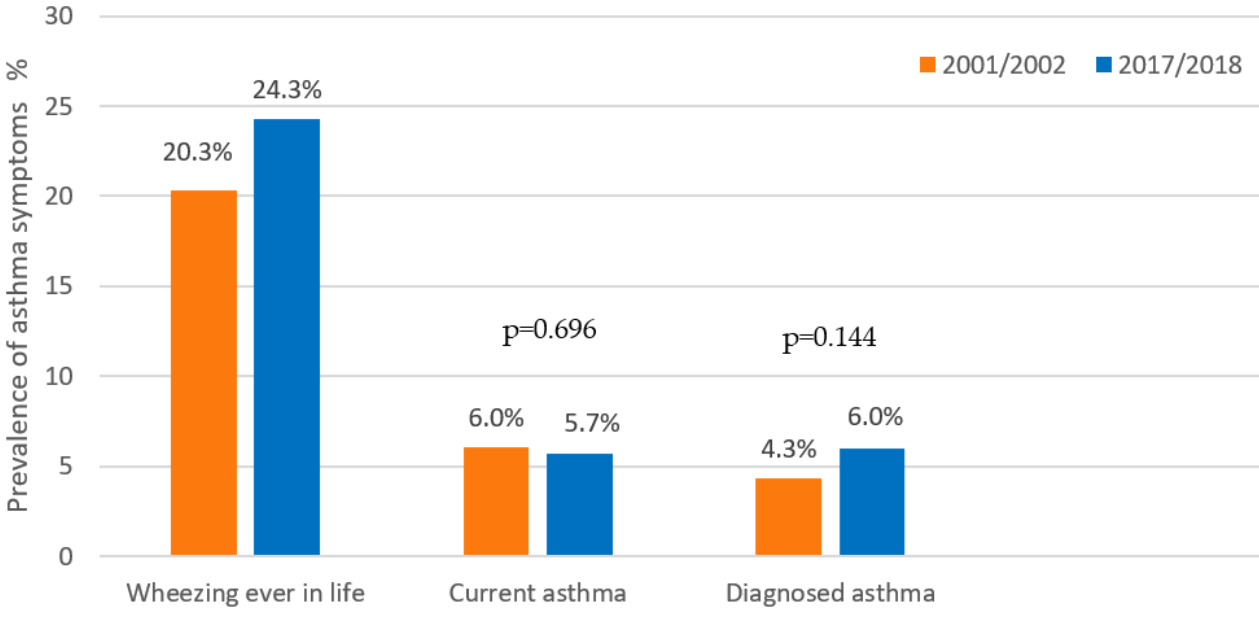
Figure 1. Comparison of asthma symptoms and diagnosis prevalence, 2002–2018. The estimated self-reported prevalence of current AR in 2018 was 35.7%. The preva- lence of AR symptoms ever-in-a-lifetime increased significantly by 28% ( p < 0.001), current rhinitis by 23% ( p < 0.001) and self-reported diagnosed AR by 5% in comparison with the previous ISAAC study ( p = 0.006) (Figure 2).